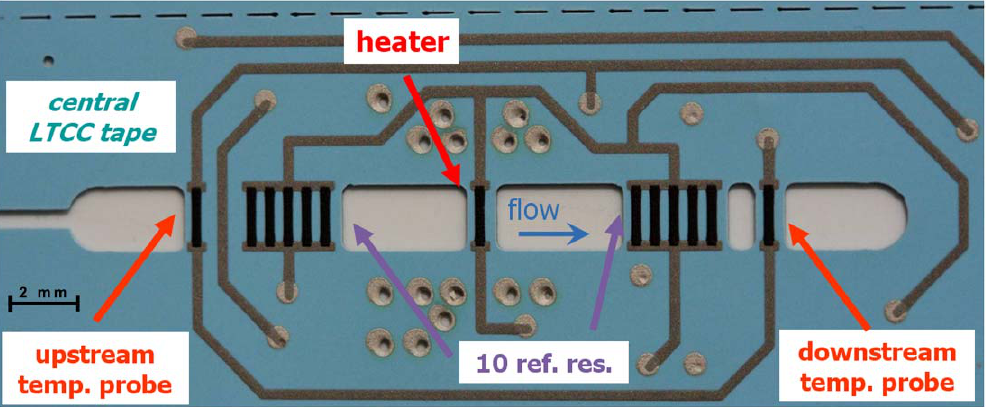
Figure 3. Central LTCC tape (T3) showing the flow + temperature sensor sections. The heater resistor is surrounded by Ag thermal vias; conductor tracks are in